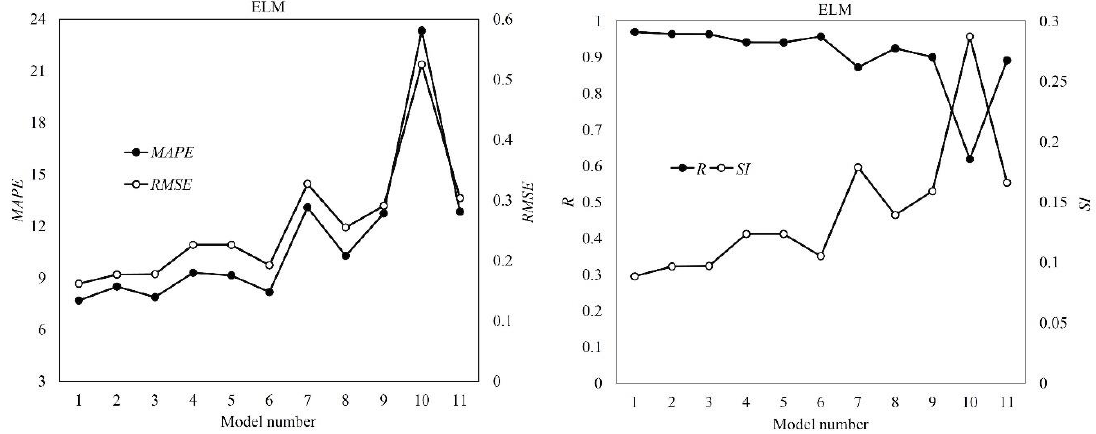
Figure 5. Comparison of different input combinations in abutment scours depth prediction.